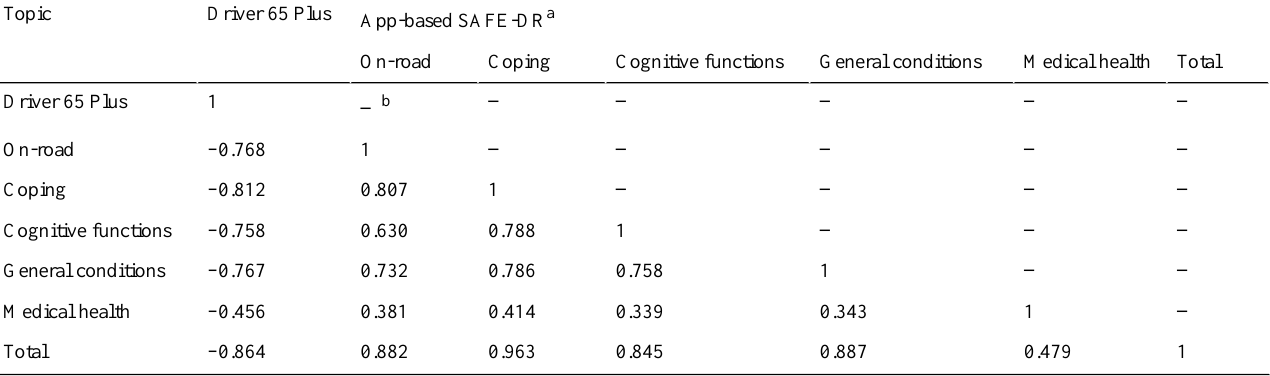
Table 5. Correlation between Self-Report Assessment for Elderly Driving Risk and Driver 65 Plus (n=81). App-based SAFE-DR a Driver 65